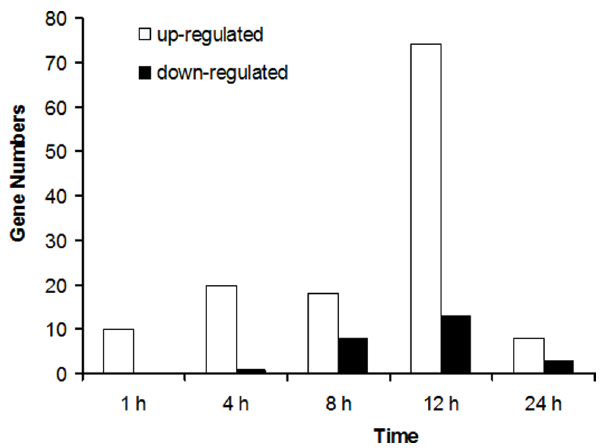
Figure 2. Screening of more than 2-fold differentially ex- pressed genes in B.mori hemocytes after the treatment of DA in